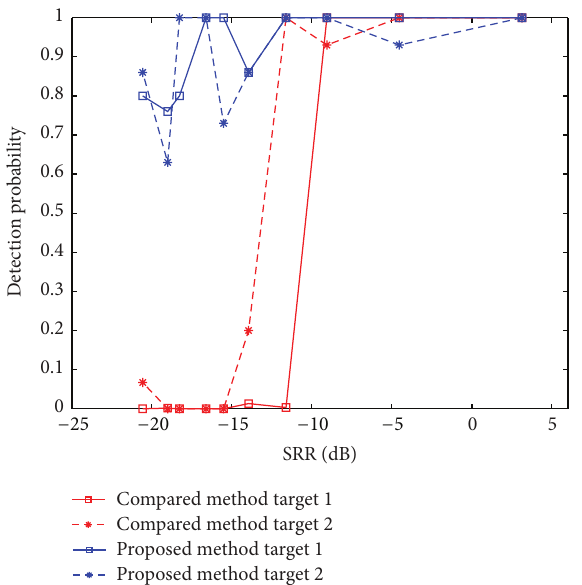
Figure 8: Detection probabilities of two targets with proposed detection methods over different SRR values and SNR is equal to − 15dB.